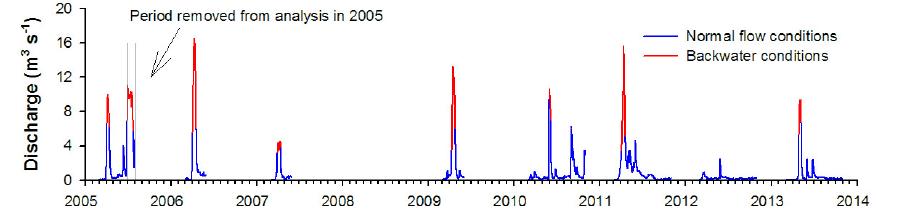
Figure 2. Yearly hydrographs indicating periods of potential backwater issues. The years of 2002 and 2003 are not presented since these years did not have backwater issues. The years of 2004 and 2008 were not included in the analysis since quality issues were identified in the metadata of the records. The periods between lines in 2005 indicate the records removed from the dataset during model assessment.